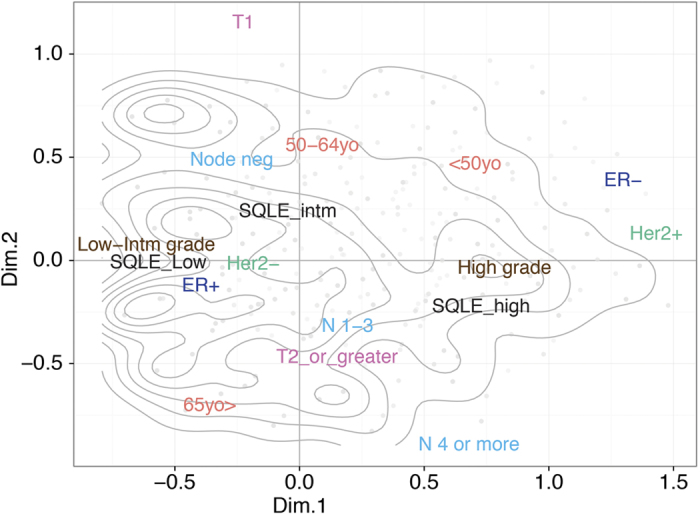
Multiple correspondence analysis (MCA) defines the structure of clinical and pathological associations with SQLE gene expression in breast cancer.x- and y-axes represent the first and second dimension (Dim.1 and Dim.2) of the MCA analysis performed on clinical and pathological data, as well as SQLE expression, from 1,663 breast cancer patients reported in the METABRIC dataset. The contour lines display areas of similar sample density, with smaller circles representing peaks in such density. Grey dots represent individual patients, with darker shades indicating more data points falling in the same MCA region. Variable categorical levels are automatically positioned according to their correlations with such dimensional reduction vectors and with each other. In particular, patients with high-grade tumors also show low SQLE expression levels (bottom right region), whereas the cluster of patients with SQLE low expresser tumors is also characterized by low and intermediate (Low/Intm) grade, Her2-, ER + cancers (center left region).